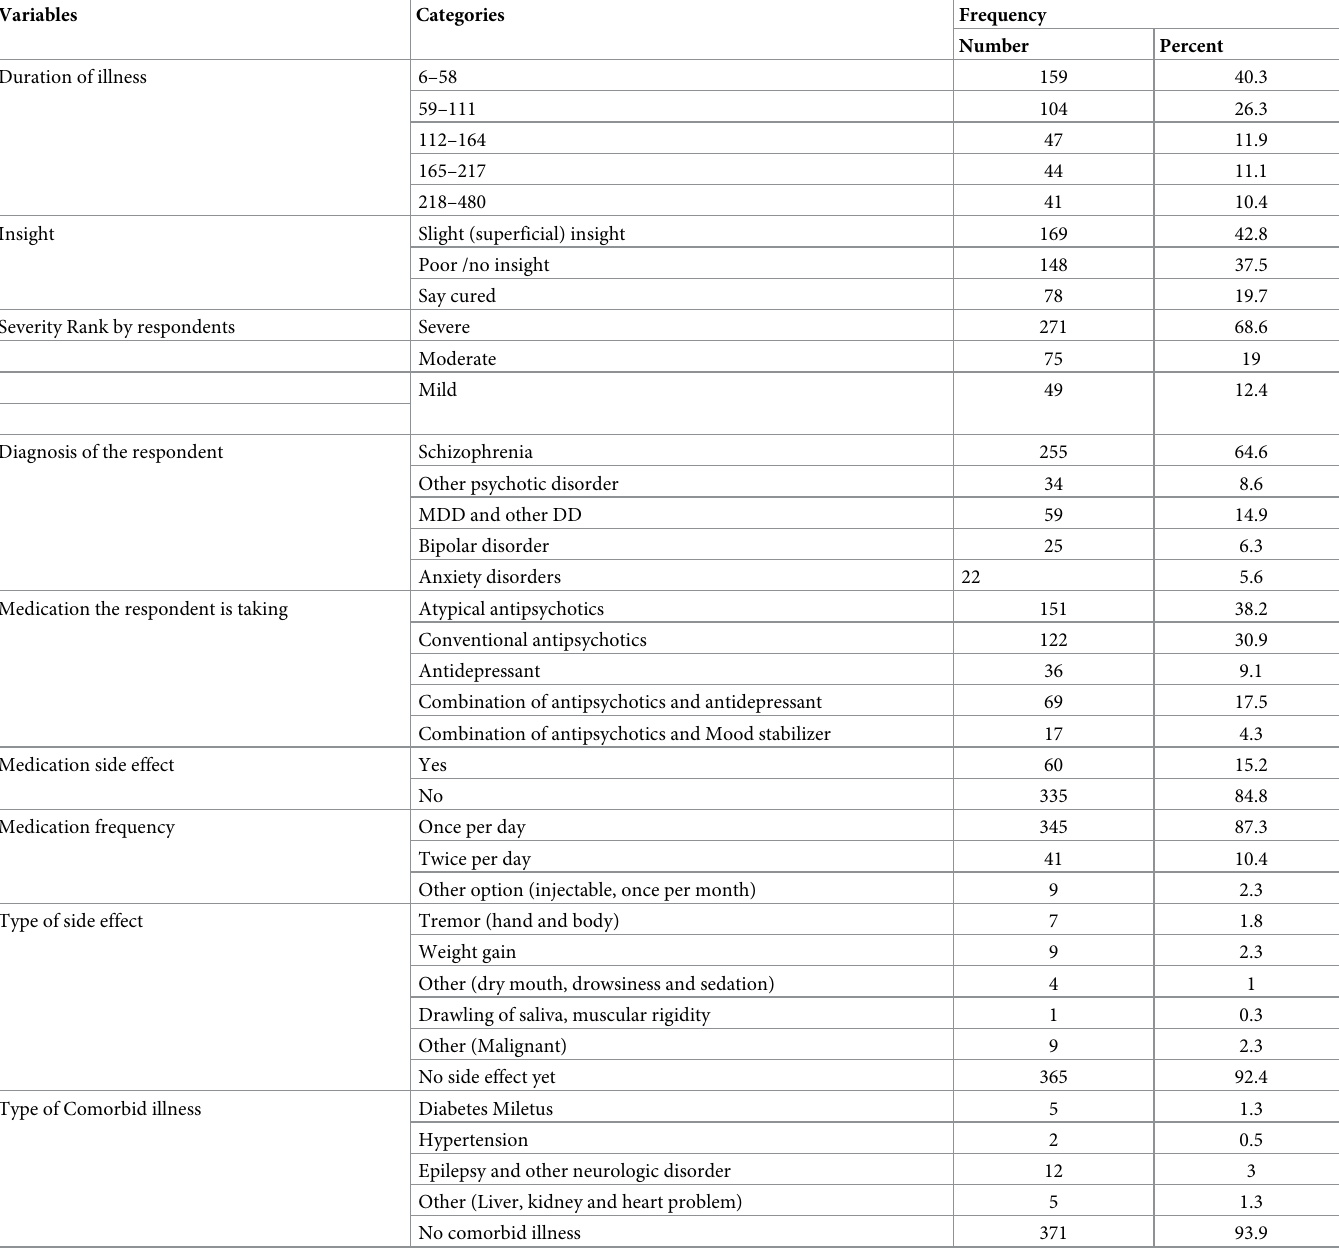
Table 4. Frequency distribution of respondents by clinical factors in Asella Referral and Teaching Hospital